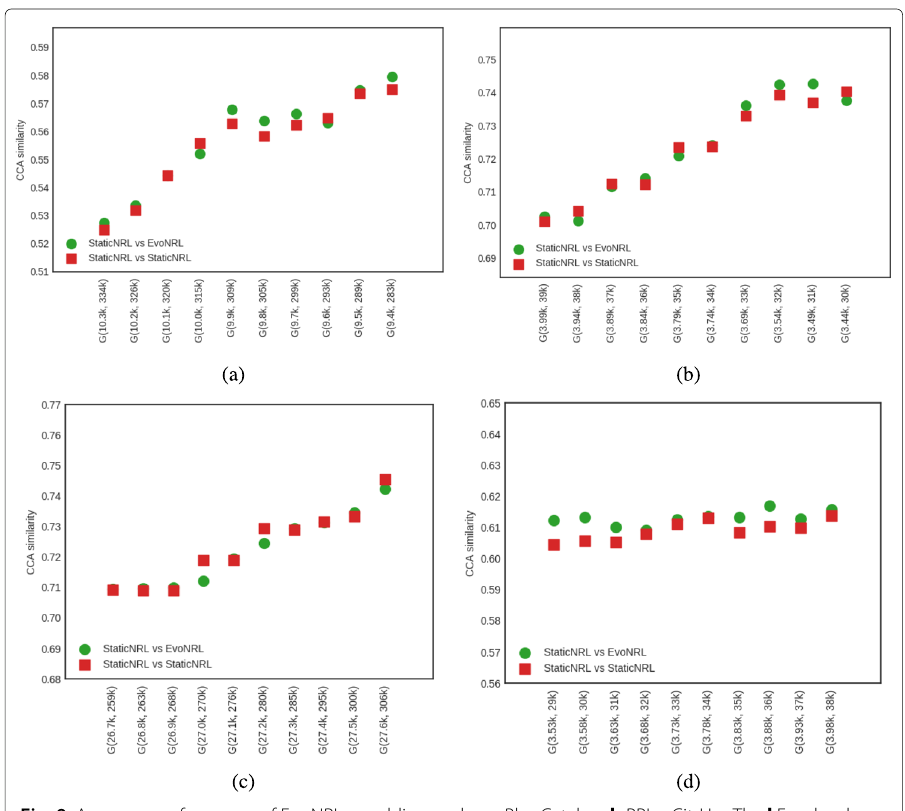
Fig. 9 Accuracy performance of E VO NRL — adding nodes. a BlogCatalog, b PPI, c Cit-HepTh, d